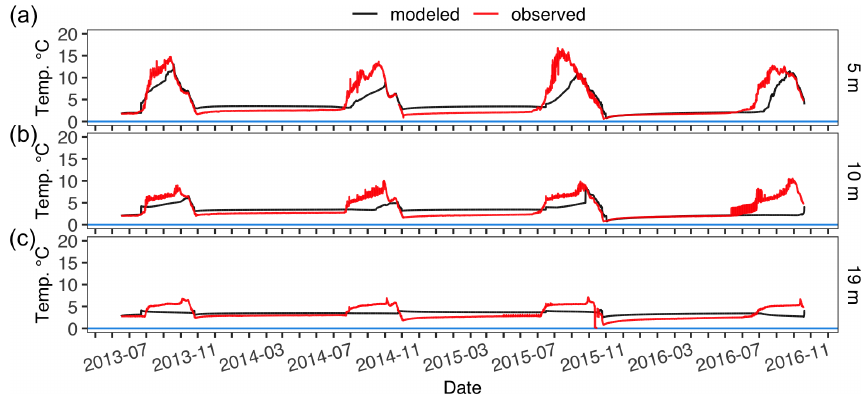
Figure B2. Modeled and observed lake water temperature at 5m (a) , 10m (b) , and 19m (c) for Toolik Lake with no